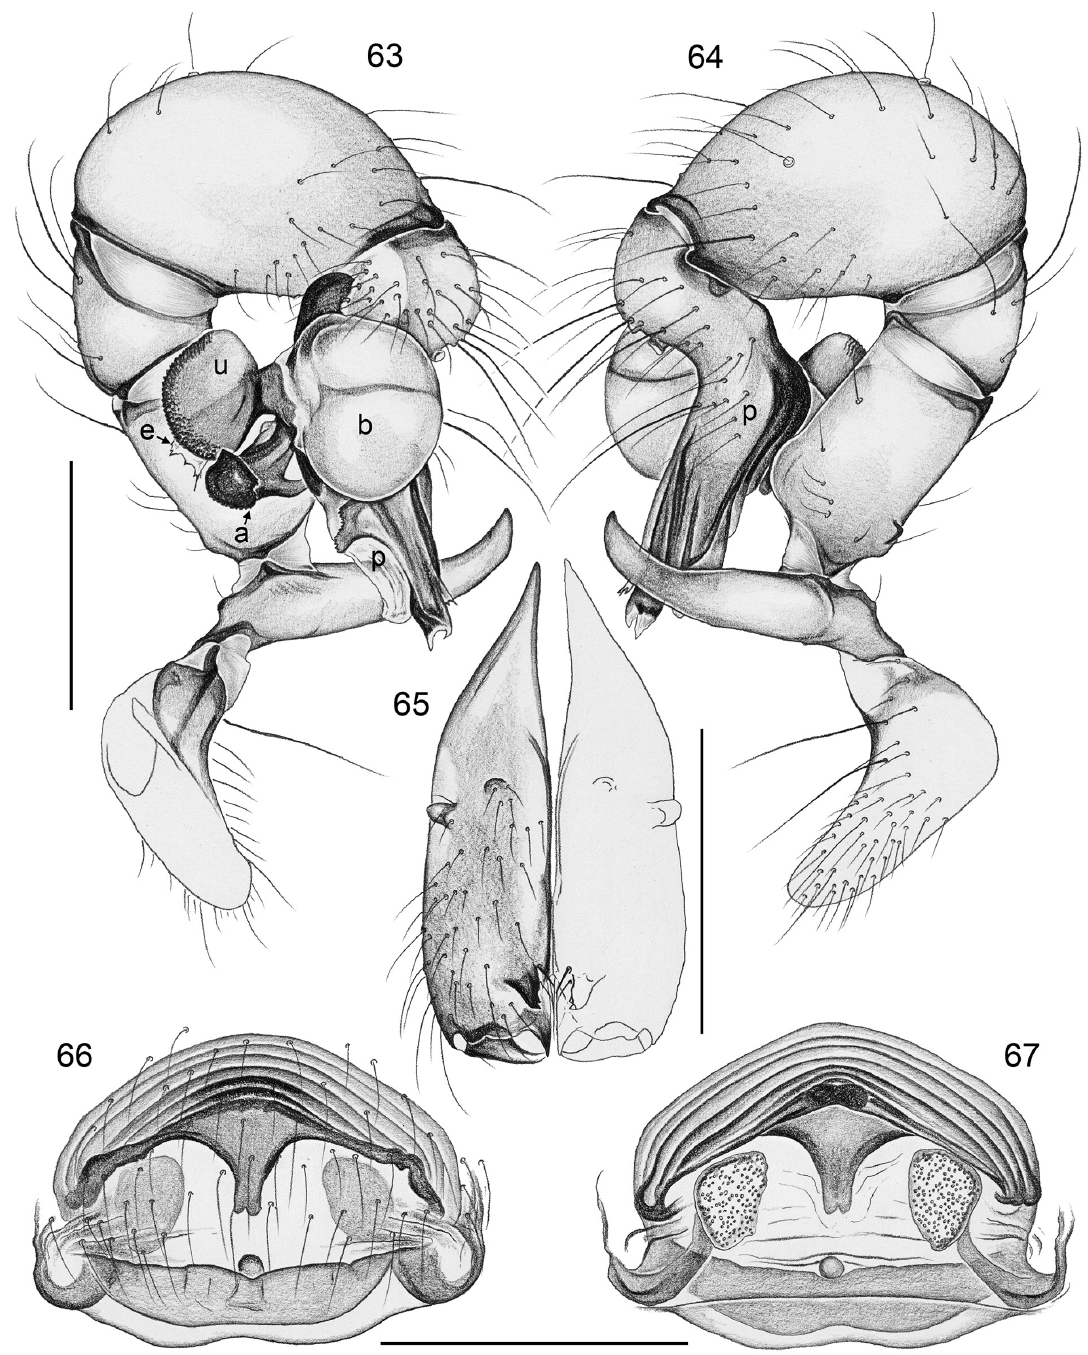
Figs 63–67. Pholcus khaolek Huber, sp. nov., ZFMK Ar 15029–30. 63–64 . Left male palp, prolateral and retrolateral views. 65 . Male chelicerae, frontal view. 66–67 . Cleared female genitalia, ventral and dorsal views. Abbreviations: a = appendix; b = genital bulb; e = embolus; p = procursus; u = uncus. Scale lines: 0.5